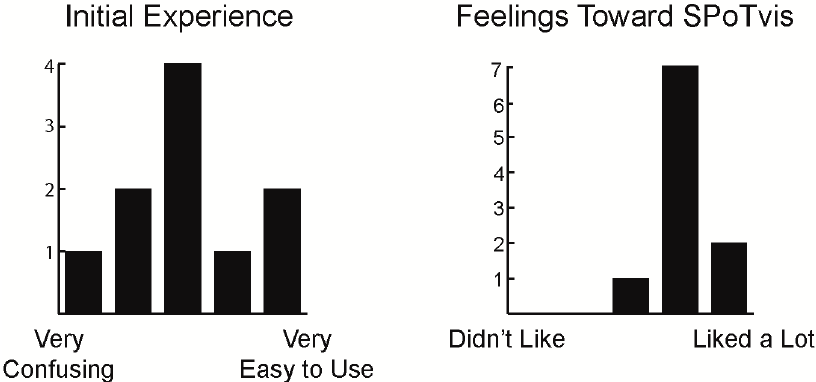
Figure 10. Initial experiences ( left ) and feelings toward SPoTvis ( right ). Each graph depicts the frequency of response on a five-step Likert scale with the end points labeled using the terms shown below the